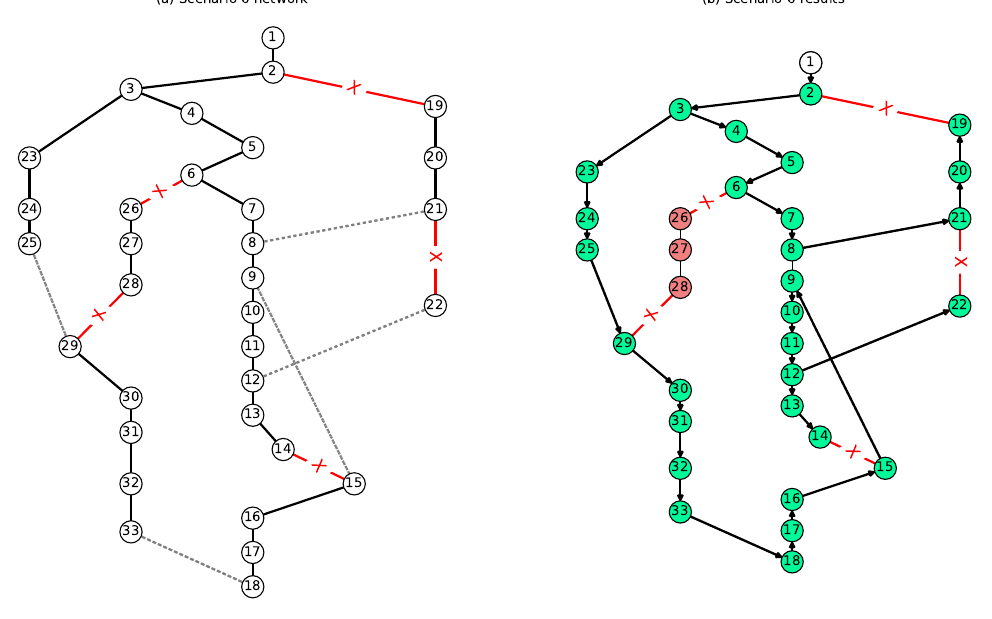
Figure 3. Obtained solution for Case